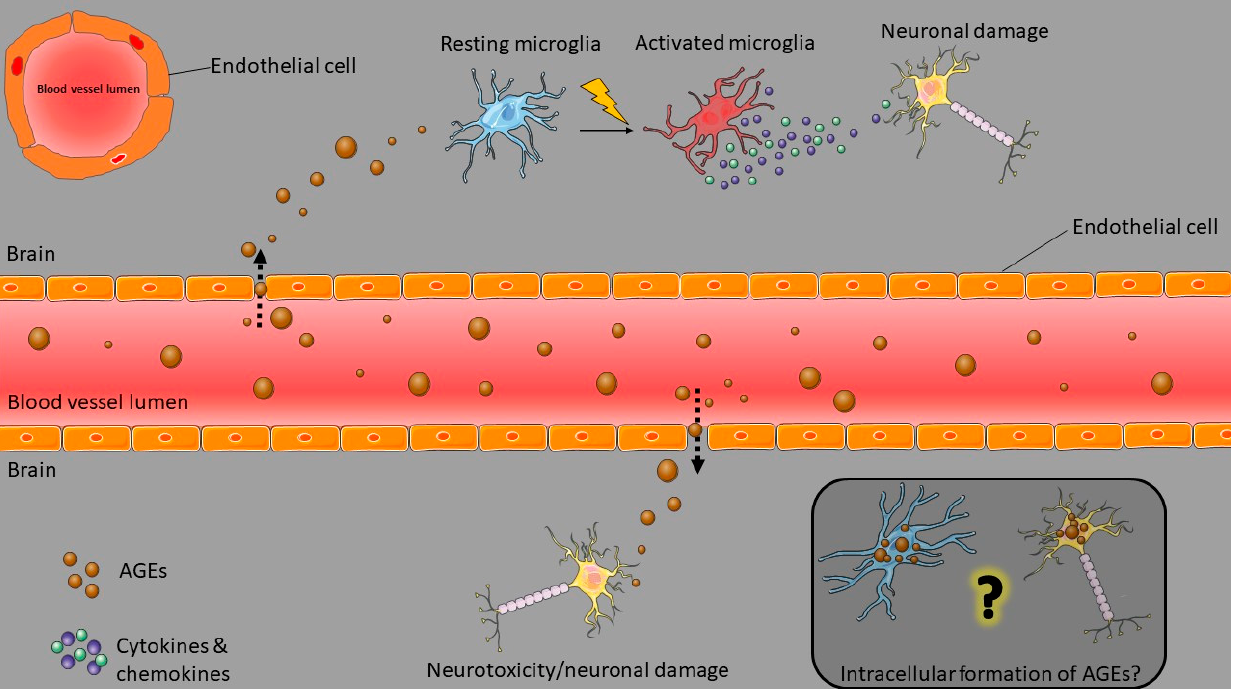
Figure 2. Concepts in AGE-mediated neurodegeneration. Circulating AGEs can disrupt the brain endothelial barrier and enter the brain. There they activate microglia and cause them to initiate an inflammatory response that can affect neuronal survival. AGEs can also have direct cytotoxic effects on neurons. Moreover, some studies have shown the intracellular formation of AGEs in microglia